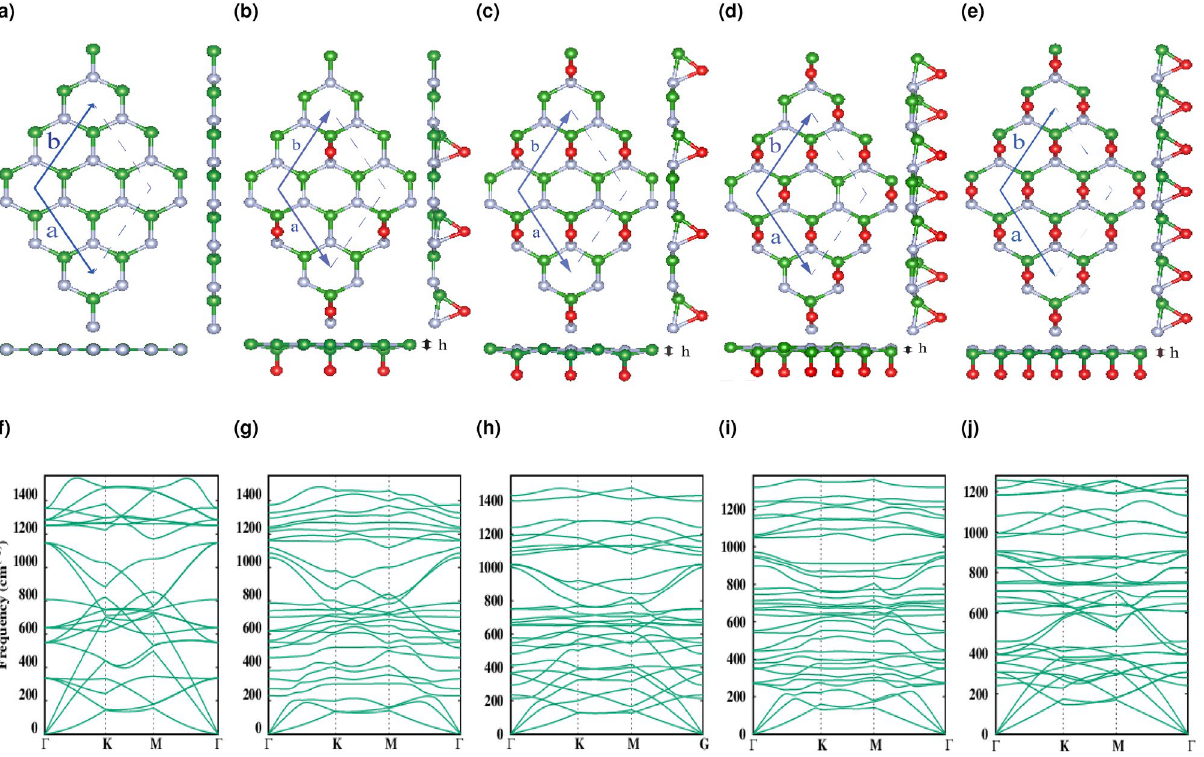
Figure 1. ( a ) Top and side view of pristine hBN. ( b – e ) Top and side view of (cid:31) = 1/8, 2/8, 3/8, and 4/8 oxygen functionalized hBN. ( f ) Phonon dispersion for pristine hBN along different high-symmetry paths. ( g – j ) Phonon dispersion for (cid:31) = 1/8, 2/8, 3/8, and 4/8 oxygen functionalized hBN along different high-symmetry that in the areas near the edges of the valence band maximum, oxygen is strongly bonded to the boron and nitrogen. On the other hand, to investigate the change of electronic bonding after oxygen functionalization, we pro- vided the corresponding total density of states (TDOS) and the partial density of states (PDOS) graphs projected on oxygen atoms in Fig. 3f–j where it is observed that the elevation of boron and nitrogen atoms after oxygen 2 adsorption changes the sp hybridization in hBN surface. As it is mentioned before the same behavior in oxygen and total contributions in DOS shows the strong hybridization in the out of plane orbitals. Here we have considered low level doping concentrations ( (cid:31) = 5.5 and 11%) by which unpaired electrons has been introduced to the structures and the adequate degree of ferromagnetism is evident, which in turn changes the electronic properties of oxygen doped hBN and consequently the appearance of spin splitted bands. From Fig. 4a,b one can see that spin down channel exhibit a wider band-gap than spin up does. As PDOS curves in Fig. 4c,d show there are more electronic states in the spin up channels which are mainly contributed by the O